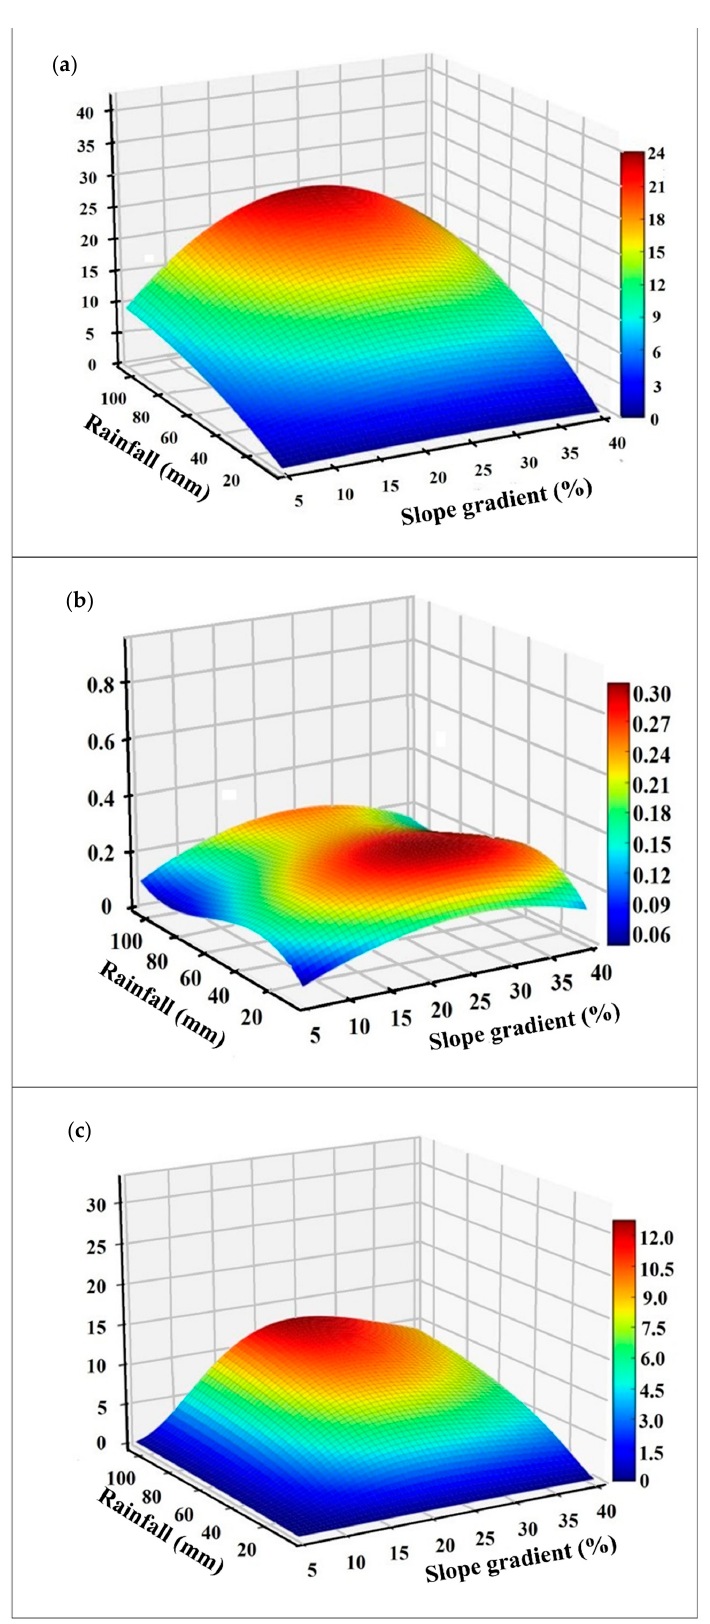
Figure 5. ( a ) Predicted runoff, ( b ) runoff coefficient, and ( c ) sediment yield at plots with different slope gradient along skid trail under various amounts of rainfall based on polynomial regression